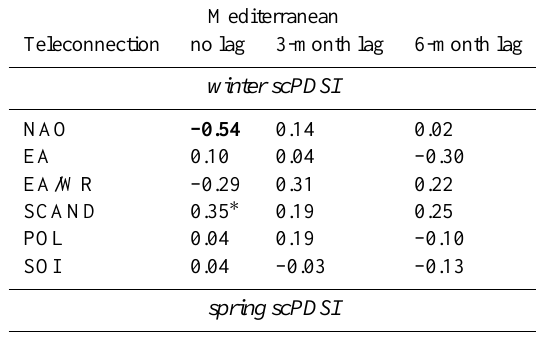
Table 3. Correlation coefficient values between Mediterranean mean scPDSI time series and the considered large-scale atmo- spheric indices – non-lagged, 3-month and 6-month lagged corre- lations between the detrended series. Taking into account the auto- correlation of the scPDSI index, values in bold ( ∗ ) are considered statistically significant at the 5% (10%)